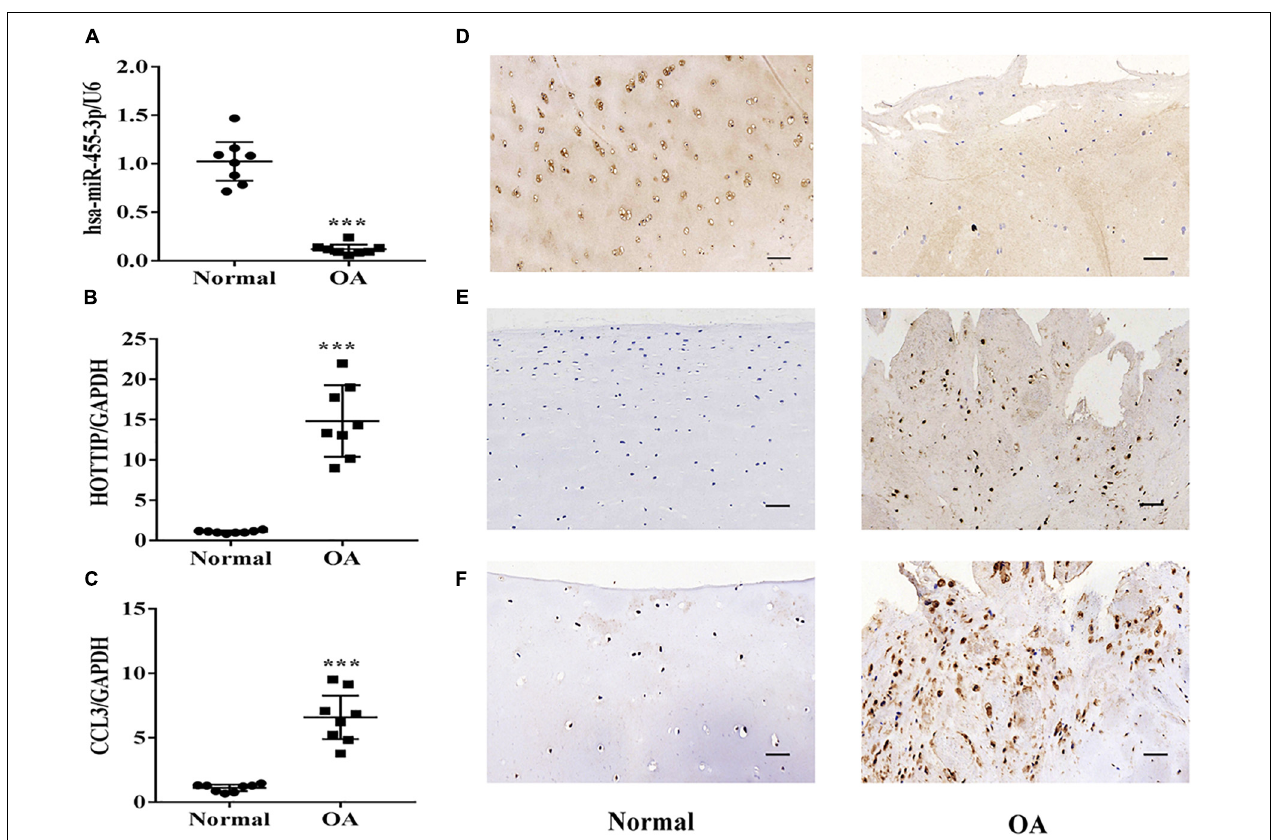
FIGURE 3 | Expression of miR-455-3p, HOTTIP and CCL3 in normal and OA cartilage. Relative miR-455-3p, HOTTIP and CCL3 mRNA levels in normal and OA cartilages were determined by RT-qPCR (A,B,C) . U6 and GAPDH were used as endogenous controls. Each dot represents a value from a single experiment of one donor. The bar shows the mean and 95% confidence intervals of the values from six different donors per group. The miR-455-3p and HOTTIP expression levels were determined in normal cartilage and OA cartilage by in situ hybridization (D,E) . CCL3 protein levels in normal cartilage and OA cartilage were determined by immunohistochemistry (F) . Data shown are representative of results from six normal and OA cartilages. Scale bar: 50 µ m. ∗∗∗ p < 0.001.